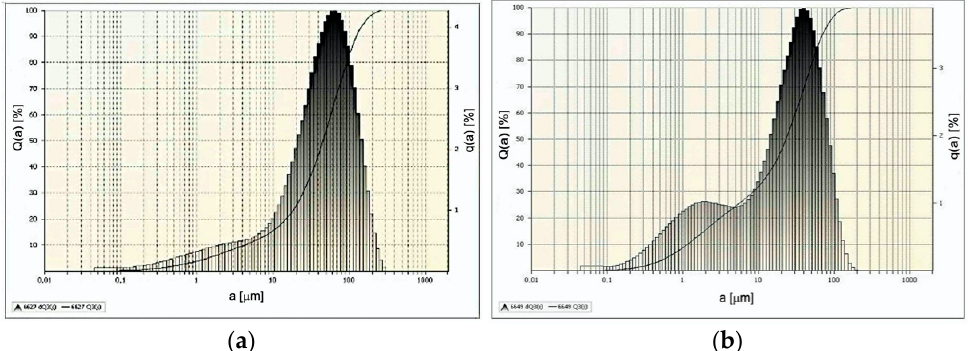
Figure 14. Example particle distributions of polymetallic nodules comminuted in a hydro-jet mill (for d w = 0.7 mm, d h = 2.4 mm, s = 10 mm) at water jet pressures: ( a ) 150 MPa, ( b ) 200 MPa.